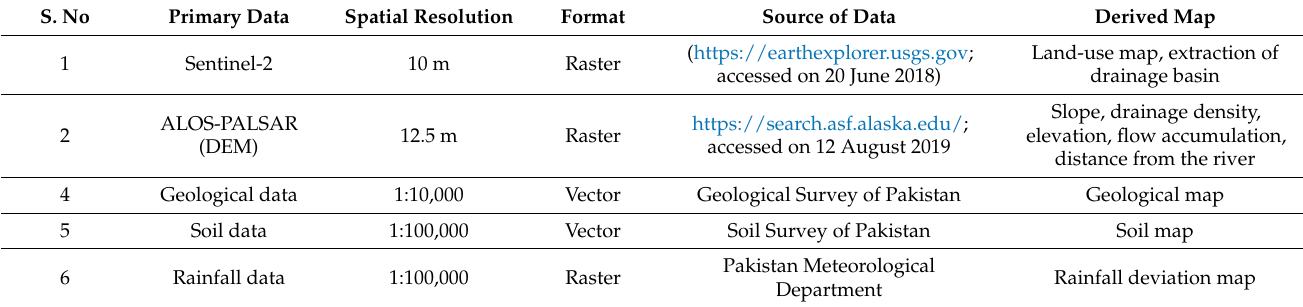
Table 1. The sources from which various data were gathered and their implementation